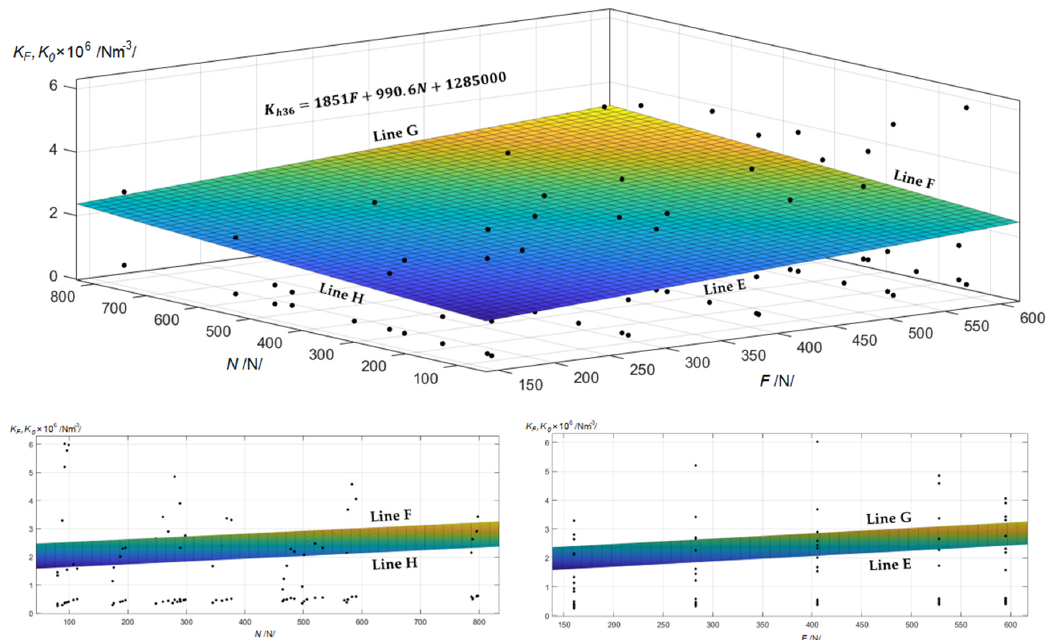
Figure 11. Approximated data with a linear function K h 36 = function ( F , N ) /Nm − 3 / for wheat layer thickness h = 36 mm.